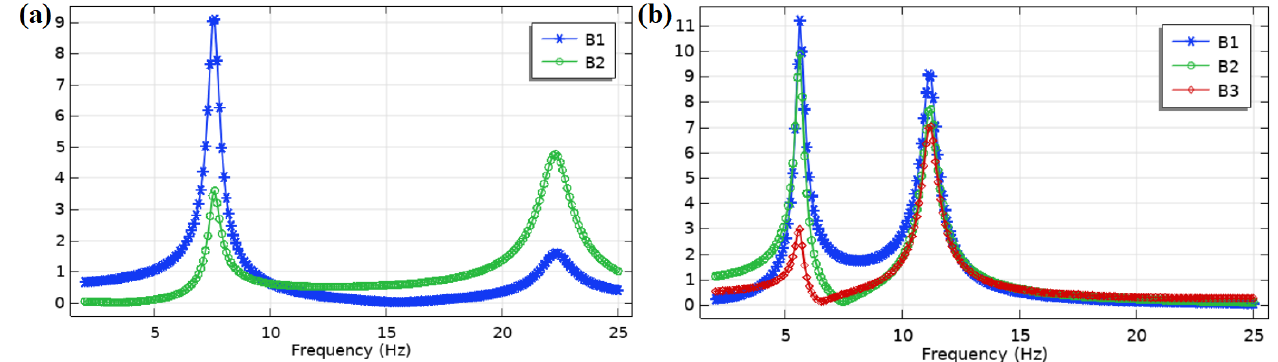
Figure 3. Open circuit voltage frequency response analysis results: ( a ) L-shaped PVEH and ( b ) U- shaped PVEH.